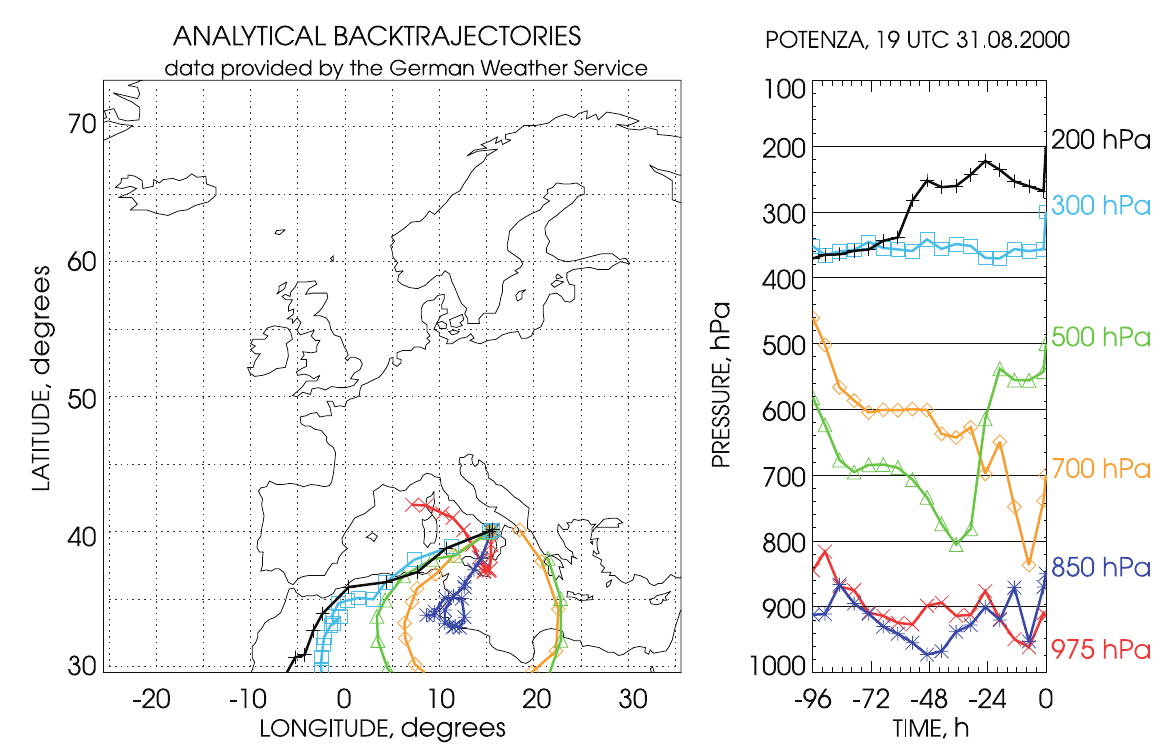
Fig. 6. 96-h air mass backtrajectory analysis for air masses ending over Potenza on 31 August, 2000 at 19